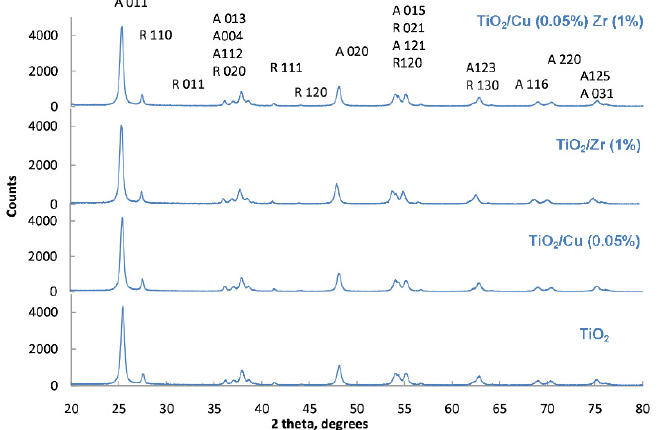
Figure 3. X-ray diffraction patterns of pure TiO 2 and Cu- and Zr-modified TiO 2 photocatalysts.